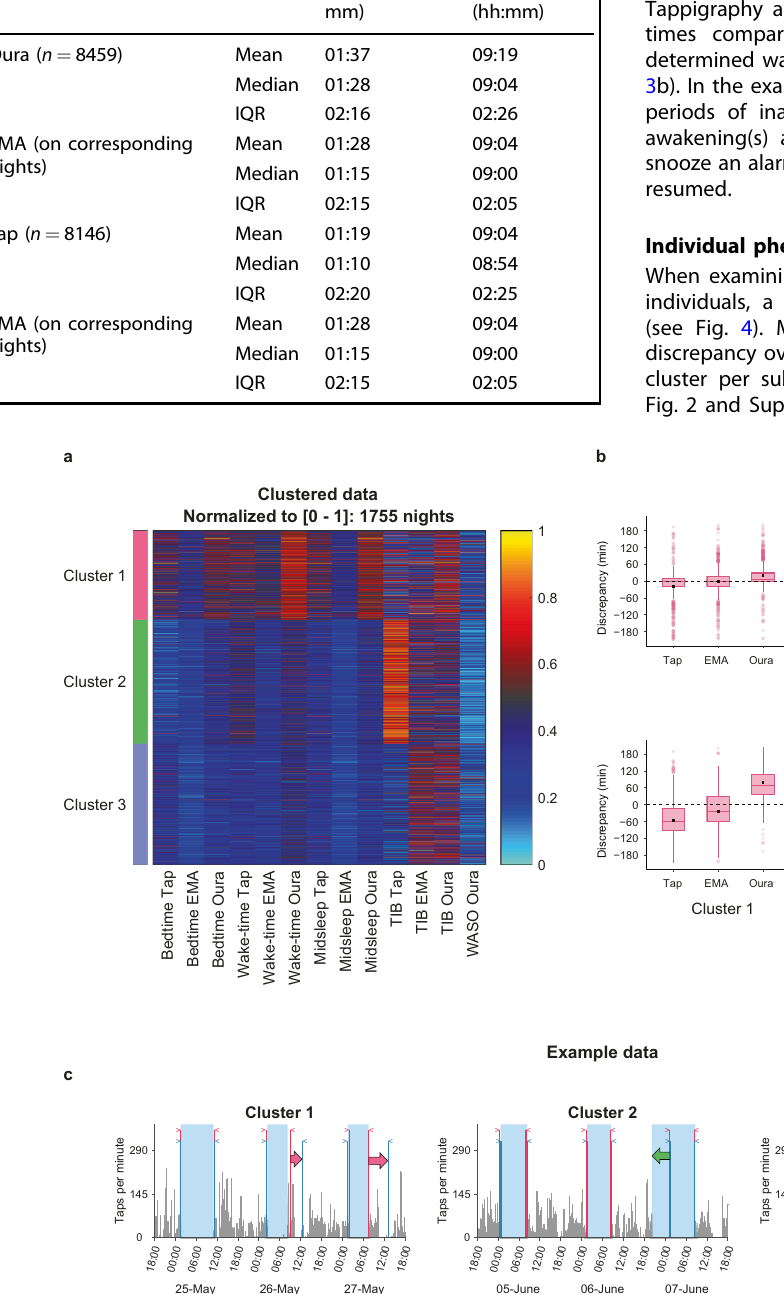
Fig. 3 Identifying patterns of modality discrepancy through clustering. a Clustering of discrepant nights based on bedtime, wake time, midsleep time and time in bed (TIB) obtained from each modality along with WASO from Oura ( n = 1755, discrepancy >1 h). Warm colors indicate later sleep timings (bedtime, wake-time, and midsleep) and longer durations (TIB, WASO) normalized per sleep metric, and cool colors indicate earlier sleep timings and shorter durations. b Plots show the discrepancy patterns for the resulting clusters for bed and wake time metrics. Estimates from each modality were compared to the overall average of the three modalities. Each boxplot displays the mean (black square) and the median (centerline) discrepancy values. The upper and lower hinges correspond to the fi rst and third quartiles, and the upper and lower whiskers extend to the furthest point within 1.5 times the interquartile range from the hinges. c Illustrative samples of daily phone tap activity with sleep timings from the three modalities for each high-discrepancy cluster. Cluster 1: delayed Oura wake times (26th/27th May). Cluster 2: earlier tappigraphy-based bedtime relative to Oura and EMA (7th June). Cluster 3: earlier tappigraphy-based wake time (13th